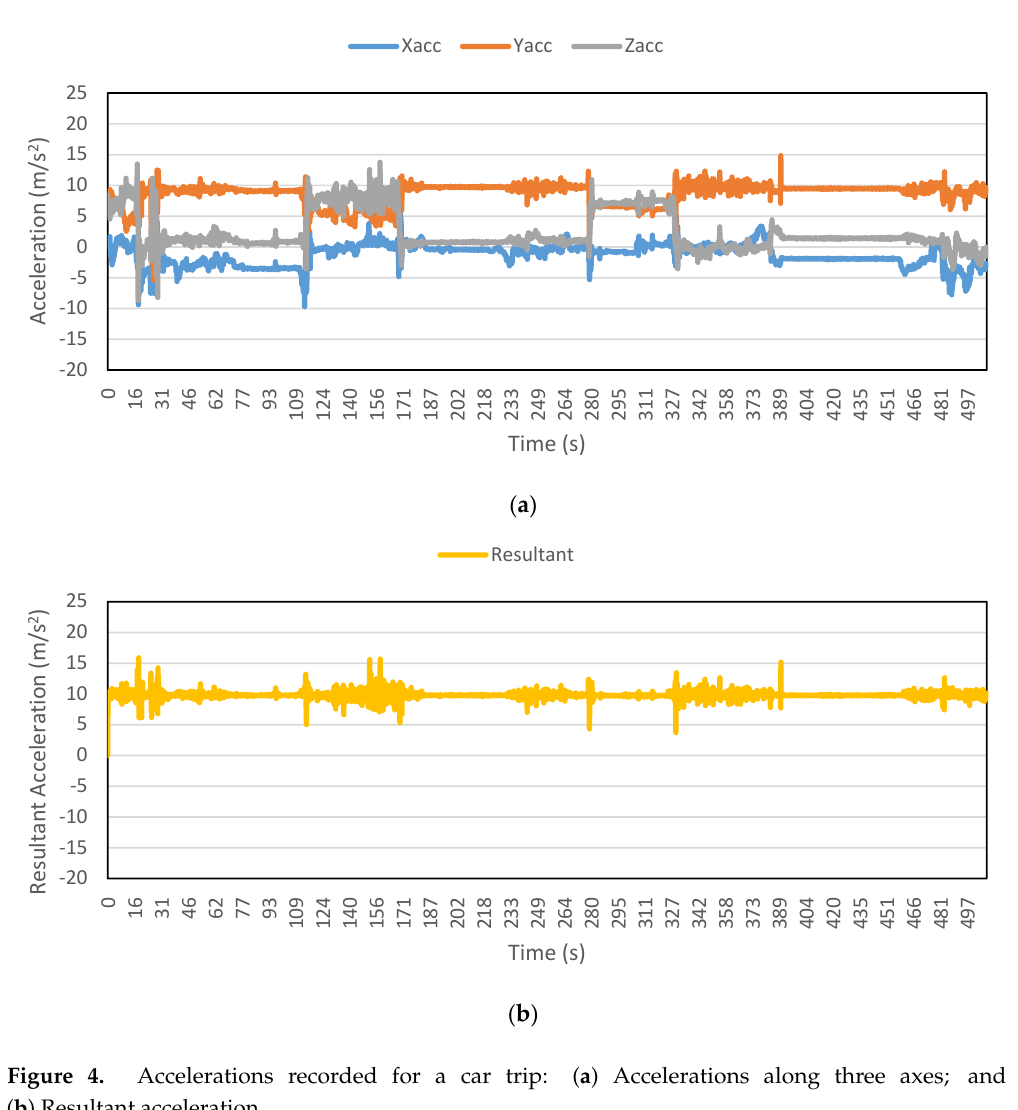
Figure 4. Accelerations recorded for a car trip: ( a ) Accelerations along three axes; and ( b ) Resultant acceleration.